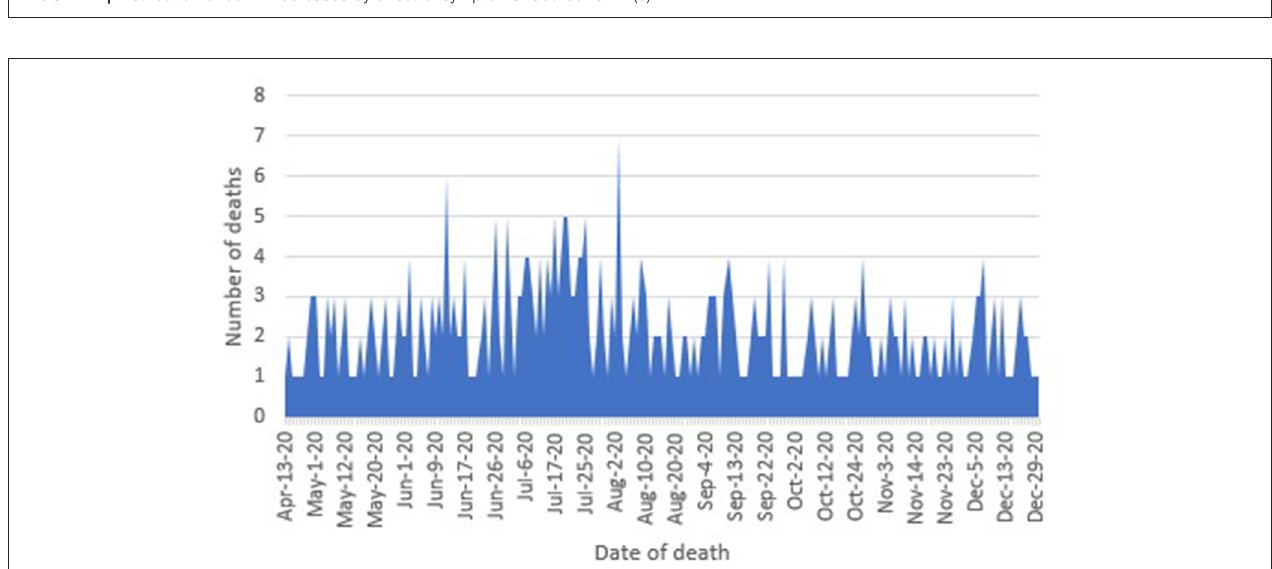
FIGURE 1 | Distribution of confirmed cases by onset of symptoms. Source: GDE (8).